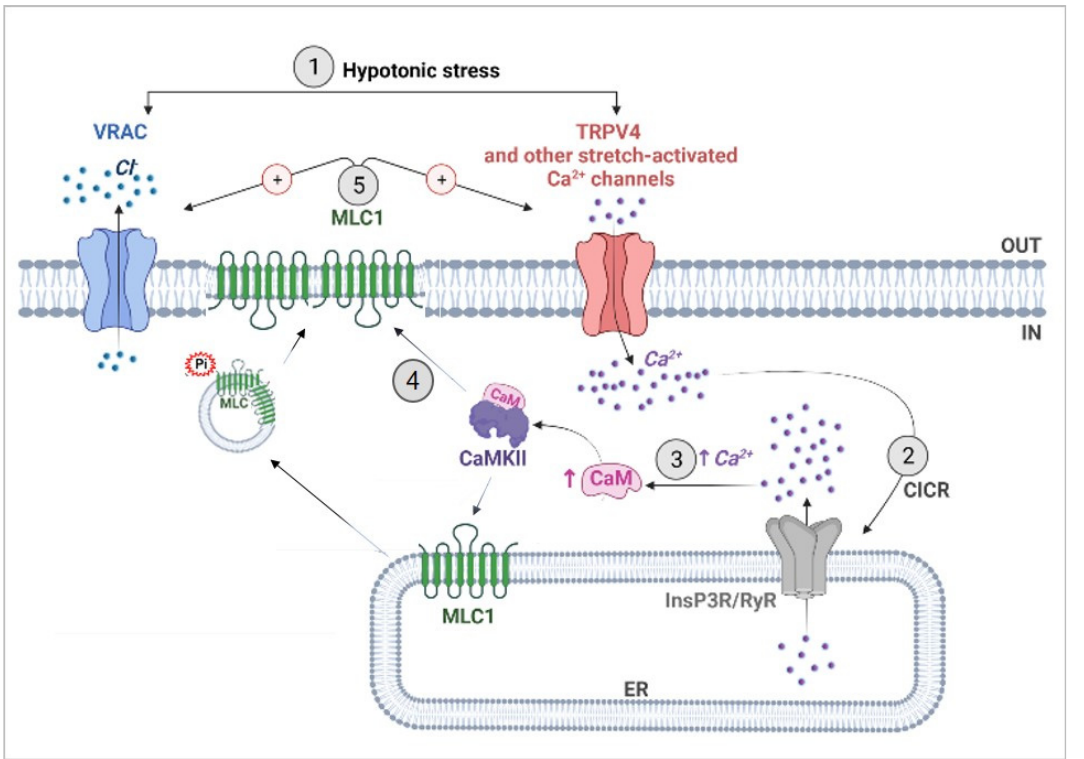
Figure 8. Scheme showing the proposed molecular mechanisms of the MLC1-induced Ca 2+ regulation of VRAC. (1) Exposure to a hypotonic stress induces astrocyte (or astrocyte end-feet) swelling, which triggers the opening of TRPV4 and other Ca 2+ channels (voltage-dependent and mechanosensitive Ca 2+ channels). (2) The entry of extracellular Ca 2+ promotes Ca 2+ release from the ER, likely mediated by the InsP3 (or/and Ryanodine) receptors, through the CICR mechanism. (3) The consequent elevation of intracellular Ca 2+ is sensed by the Ca 2+ -binding protein calmodulin (CaM), which binds and activates CaMKII. (4) By binding MLC1 and phosphorylating the threonine aa at position 17 (T17), CaMKII promotes MLC1 dimerization, stabilization, and functional activation. (5) Phosphorylated MLC1 potentiates TRPV4 [20] and VRAC channels, favoring ICl, swell and regulatory volume decrease. Dysfunction of NVU and of cerebral blood flow are also implicated in the pathogenesis of cerebral disorders, such as traumatic brain injury, Alzheimer’s (AD) and Parkinson’s (PD) diseases, multiple sclerosis (MS), and glioblastoma malignancy [58,66]. Interestingly, increased expression of MLC1 at the perivascular astrocyte end-feet has been observed in the brain of patients affected by AD, MS, and also prion disease [31], which might indicate an attempt to ameliorate these pathological processes by increased MLC1 expression in activated astrocytes. In this scenario, it is noteworthy that Ca 2+ release from